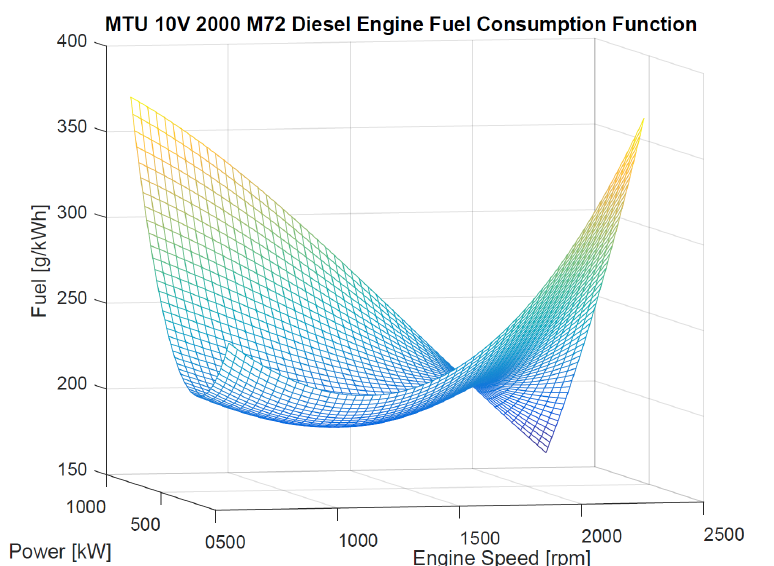
Figure 7. Engine fuel consumption